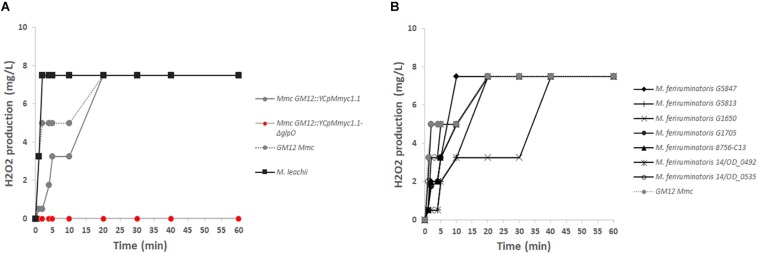
In vitro production of hydrogen peroxide. (A) The inability of the GM12::YCpMmyc1.1-ΔglpO mutant strain to produce H2O2 was compared to its parental strain GM12::YCpMmyc1.1 as well as to the wt Mmc GM12 and M. leachii PG50. (B) The capacity of Mycoplasma feriruminatoris to produce H2O2 was assessed using the type strain G5847T as well as six additional field strains detailed in Table 1.